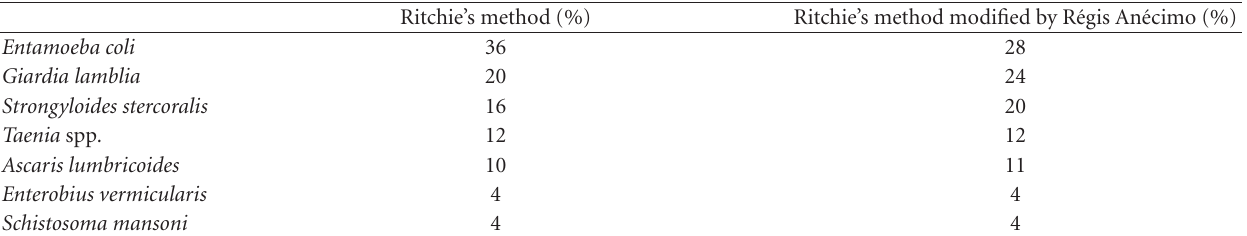
Table 1: Parasites percentage quantified by traditionally Ritchie’s method and Ritchie’s method modified by R´egis